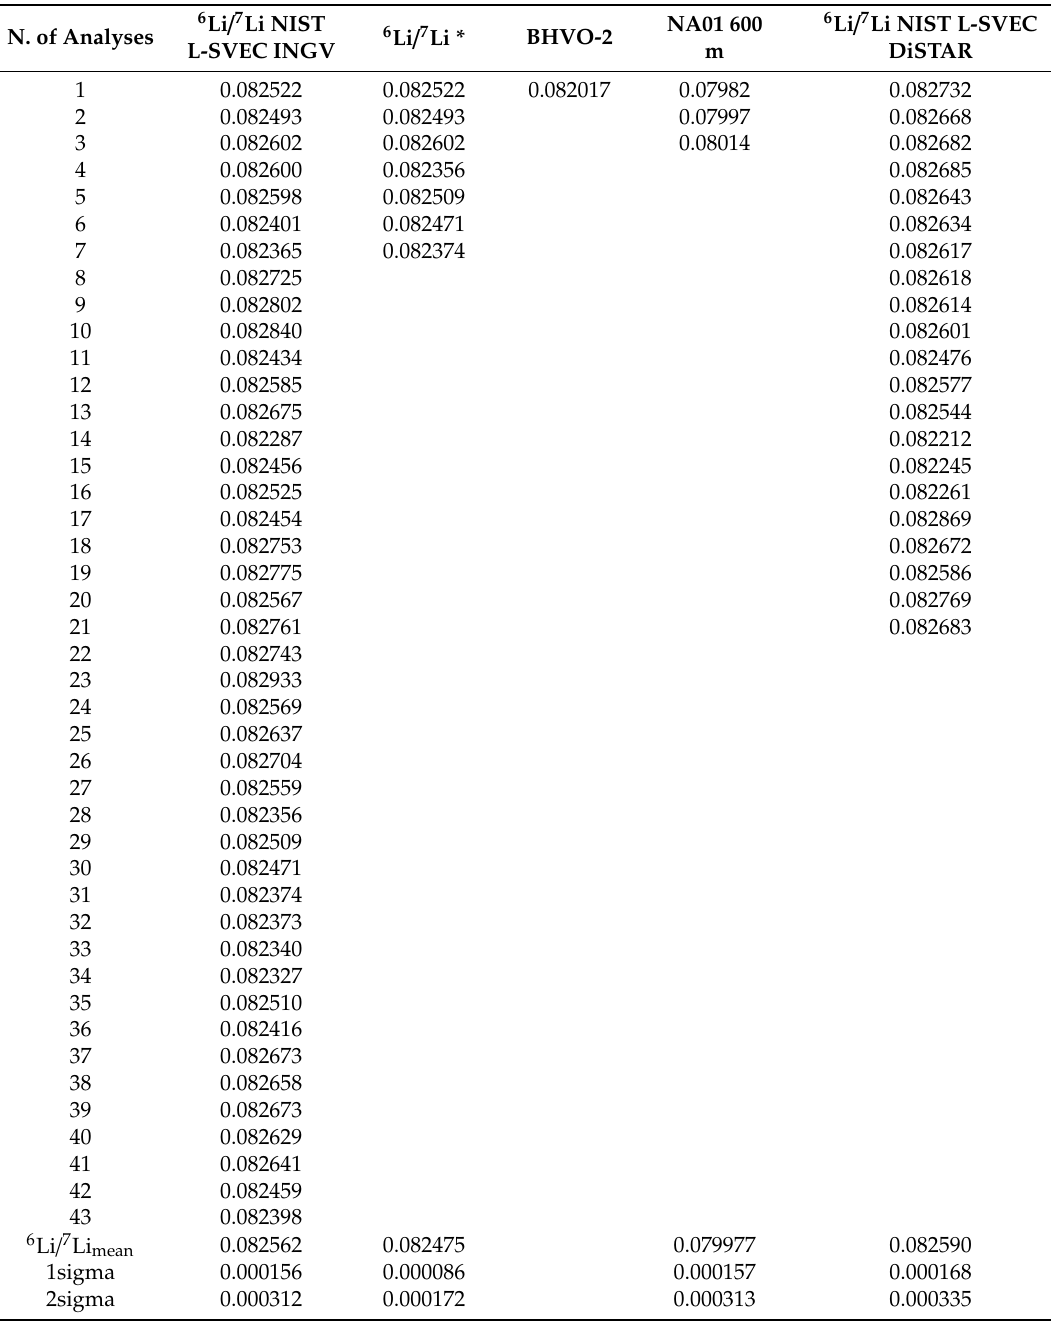
Table 1. Isotope analyses performed on natural reference samples and